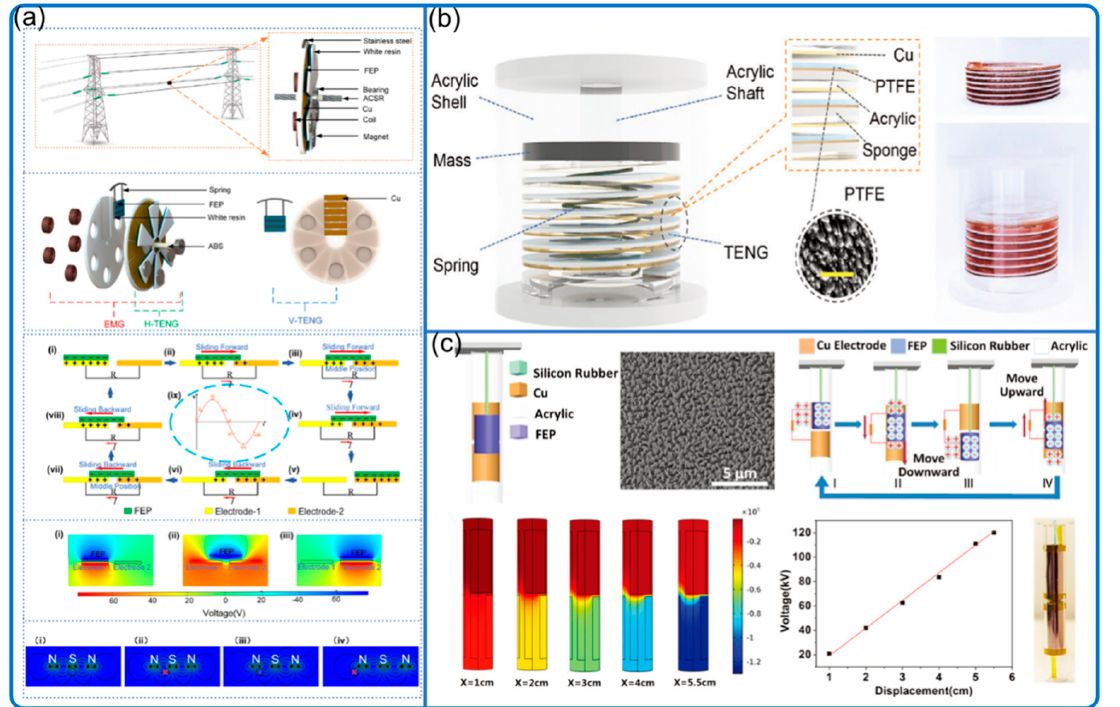
Figure 11. Structure vibration due to moving fluid. ( a ) Transmission lines galloping sensor. Reproduced with permission. Copyright 2022, Elsevier [81]. ( b ) Broadband aeolian vibration online monitoring of transmission lines. Reproduced with permission. Copyright 2022, Wiley Online Library [82]. ( c ) Bridge dynamic displacement monitoring system. Reproduced with